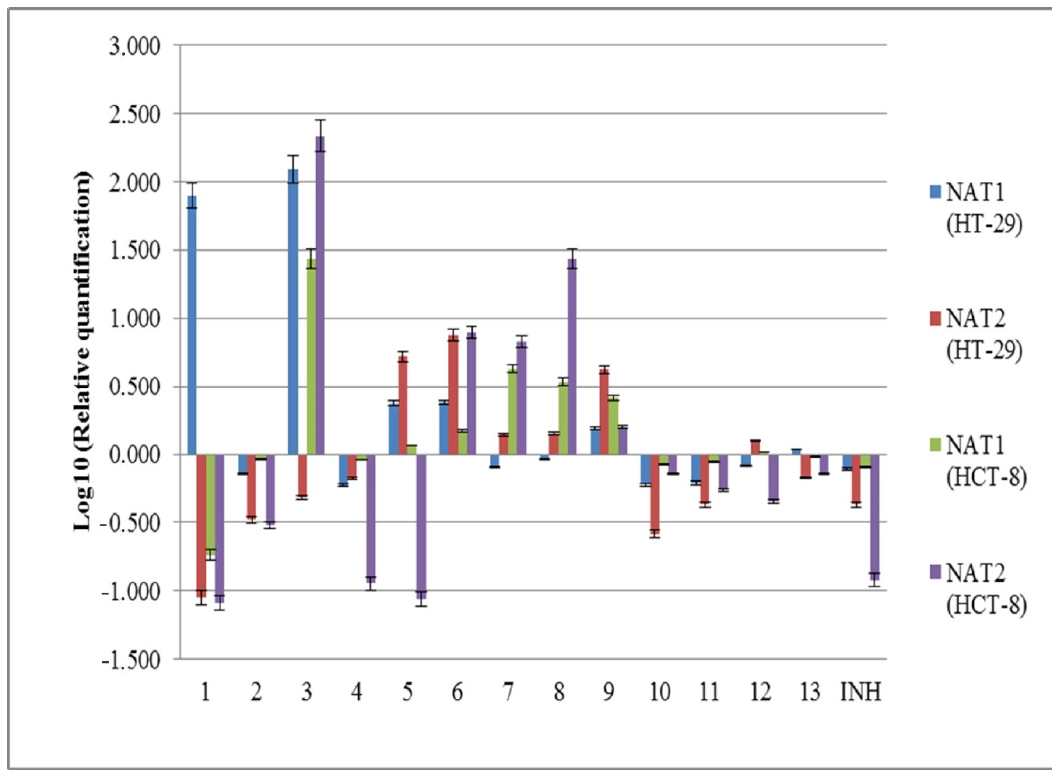
Figure 2. The influence of the new isoniazid derivatives 1 – 13 on the expression of NAT1 and NAT2 genes in HT-29 and HCT-8 cell lines.